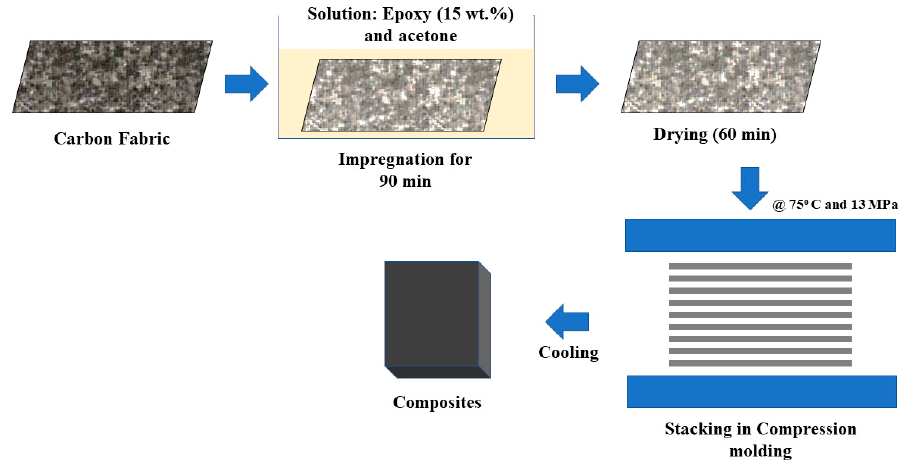
Figure 2. Schematic for the composite fabrication process.